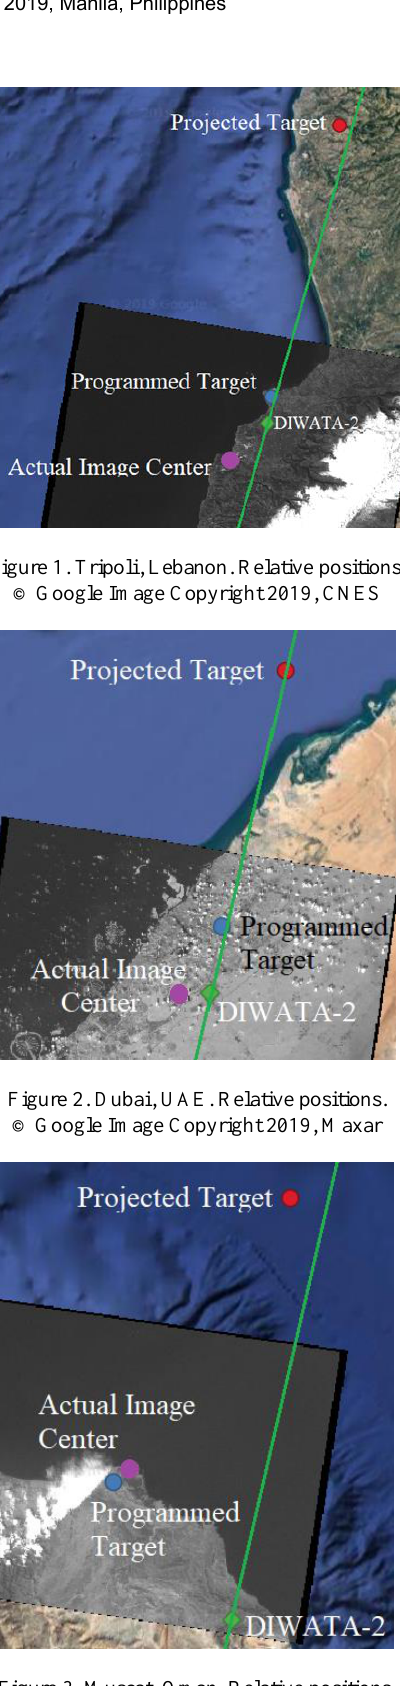
Figure 3. Muscat, Oman. Relative